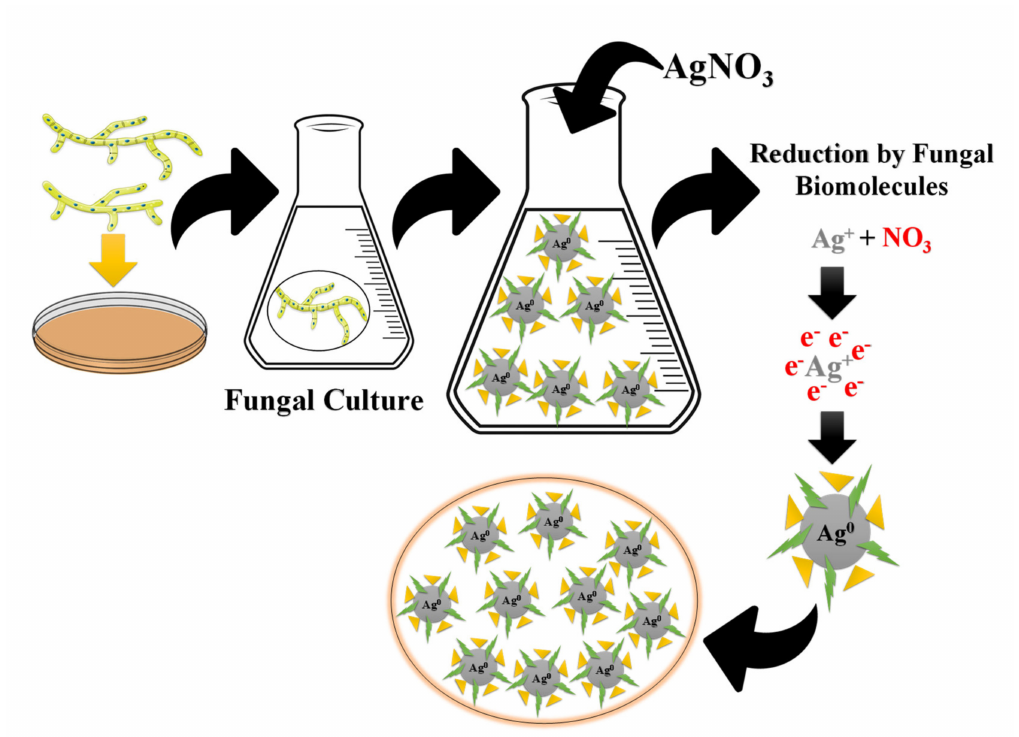
Figure 9. Mechanisms of biosynthesis of Ag NPs using fungi, modified with permission from Ref. [113], Frontiers,